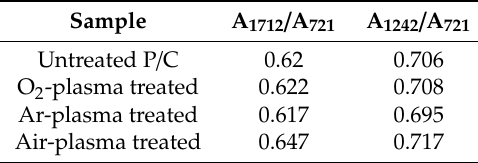
Table 2. The Absorbance ratio of the peaks in ATR-FTIR spectra of plasma treated and untreated P/C blend fabric. Sample A 1712 /A 721 A 1242 /A 721 Untreated P/C 0.62